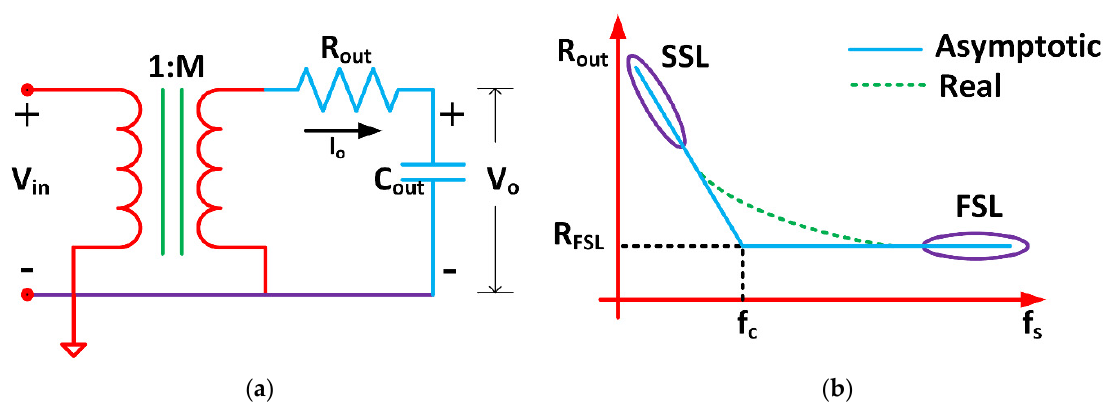
Figure 1. SC converter model and its equivalent output resistance VS frequency : ( a ) SC converter average model [19]; ( b ) output resistance of an SCPC (Switched Capacitor Power Converter) as a function of the switching frequency f s [20]. Reproduced from [19], IEEE TRANSACTIONS ON POWER ELECTRONICS: 1998 [20], IEEE TRANSACTIONS ON POWER ELECTRONICS: 2008.